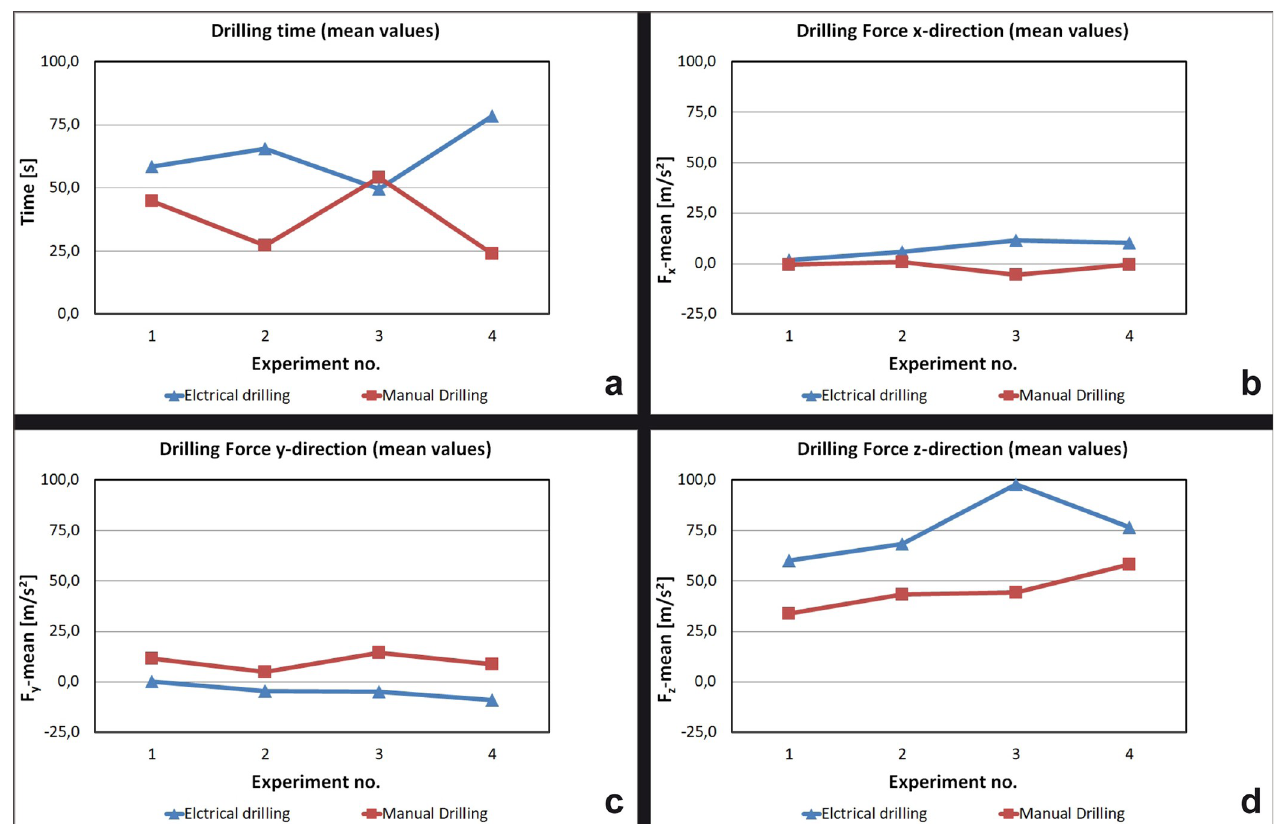
Fig 3. Drilling parameters (I). (A) Drilling time (B) Drilling Force x-direction (C) Drilling Force y-direction (D) Drilling Force